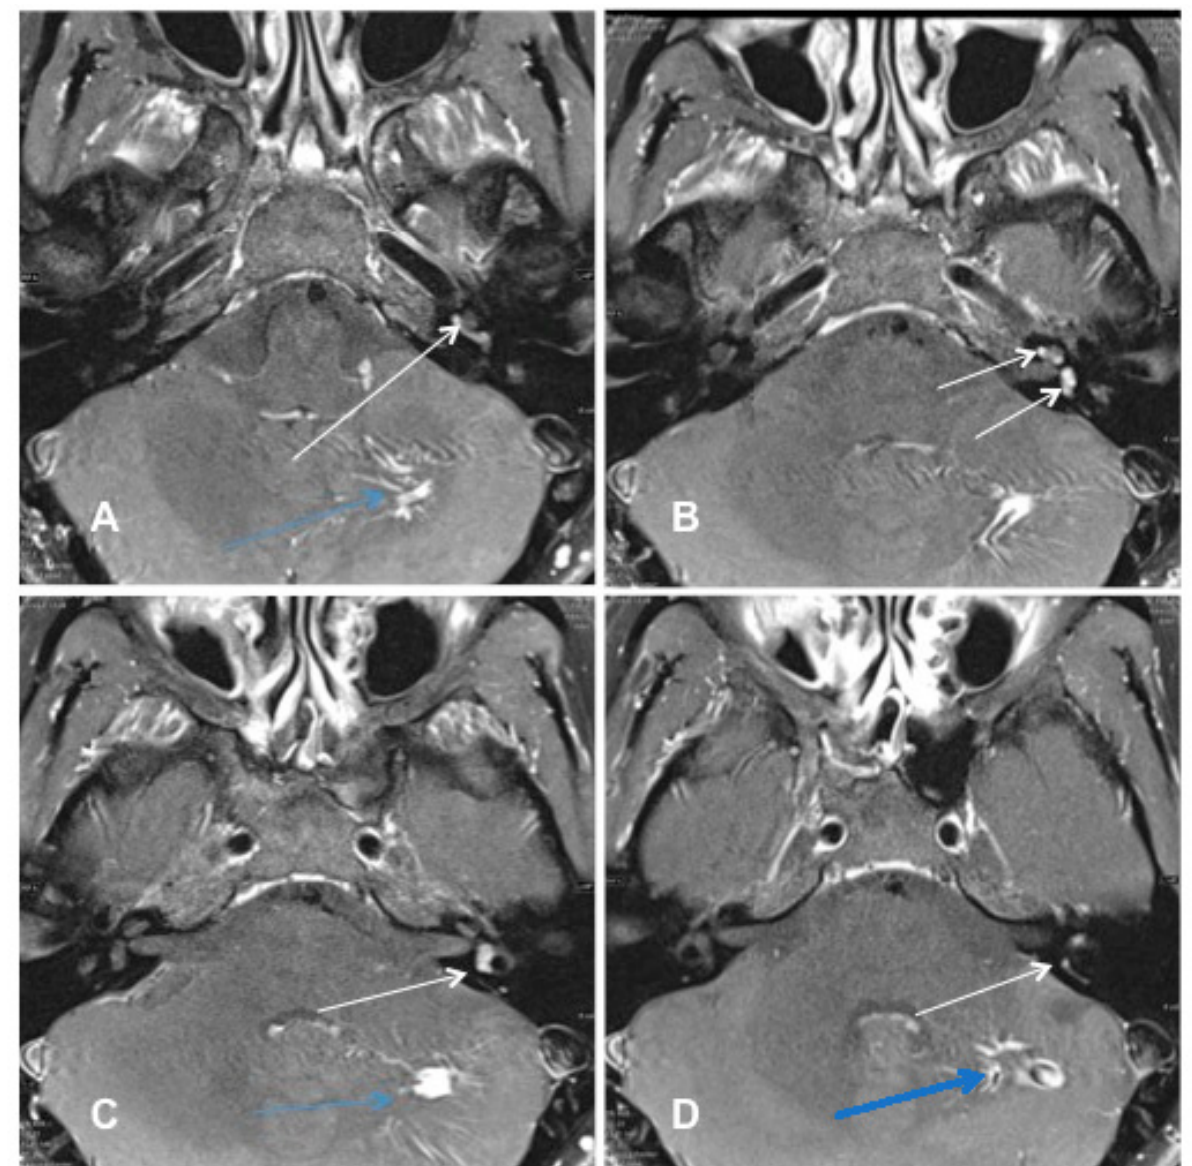
Figure 2. cMRI imaging (Case # 1). Shown are T1 weighted images with i.v. gadolinium, fat-saturated, 2 mm. The tumor had a vestibulocochlear extension from the basal turn of the cochlea to the vestibulum and ampulla of the superior and horizontal semicircular duct and their common crus. Blue arrow: venous cerebellar malformation. ( A ) Contrast-enhanced visualization of ILS in the basal cochlear turn (white arrow). ( B ) ILS in the basal cochlear turn and the ampulla of superior/horizontal semicircular duct (white arrow). ( C ) ILS in the ampulla of superior/horizontal semicircular duct (white arrow). ( D ) ILS in the common crus of the superior and horizontal semicircular duct (white arrow).